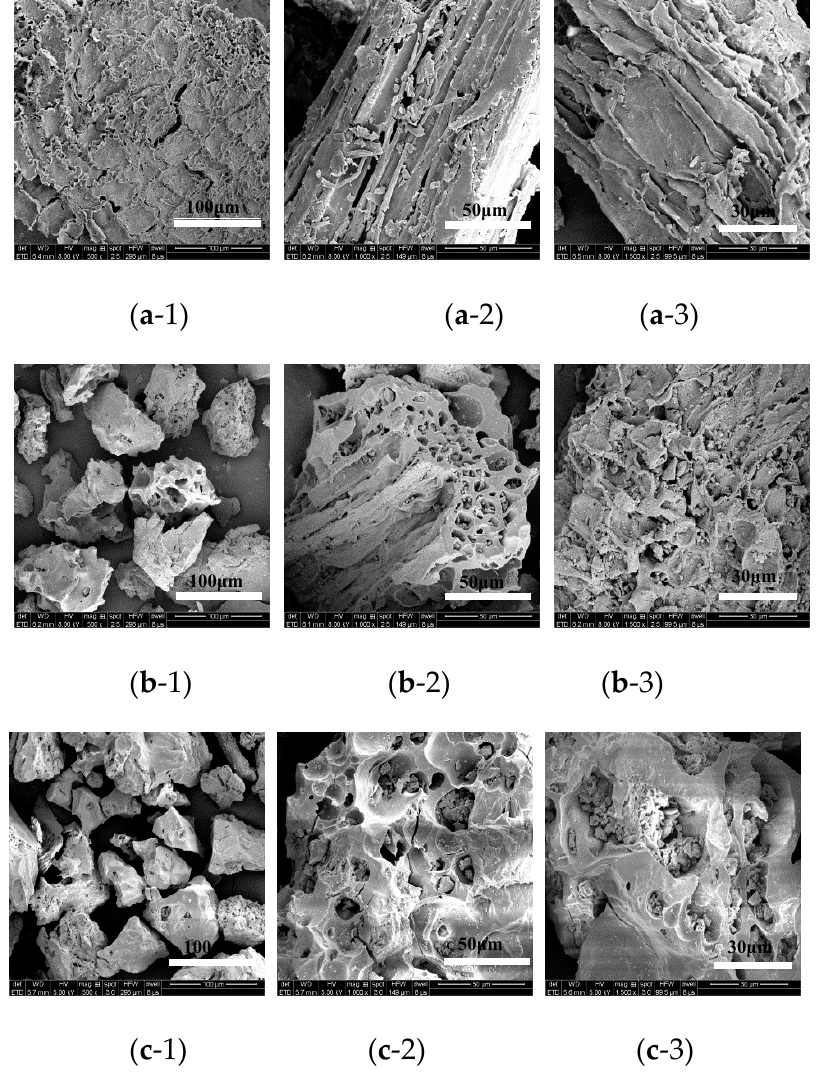
Figure 2. Scanning electron microscopy images of the ( a ) natural peat, ( b ) modified peat, and ( c ) Cr-loaded peat at (1) 500 x, (2) 1000 x, and (3) 1500 x magnification. Table 2. Specific surface areas, pore volumes and pore sizes of the natural versus the modified. Peat Type Surface Area (m 2 / Peat type